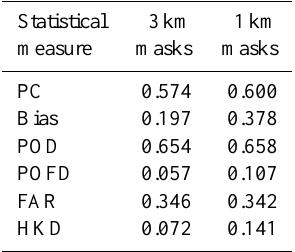
Fig. 7. Fog covering Lake Constance and adjacent valleys on 17 Jan- uary 2011. In order to achieve better comparability the 3km chan- nel was interpolated to the size of the 1km images via nearest- neighbour interpolation. Table 4. Results of the METAR validation.